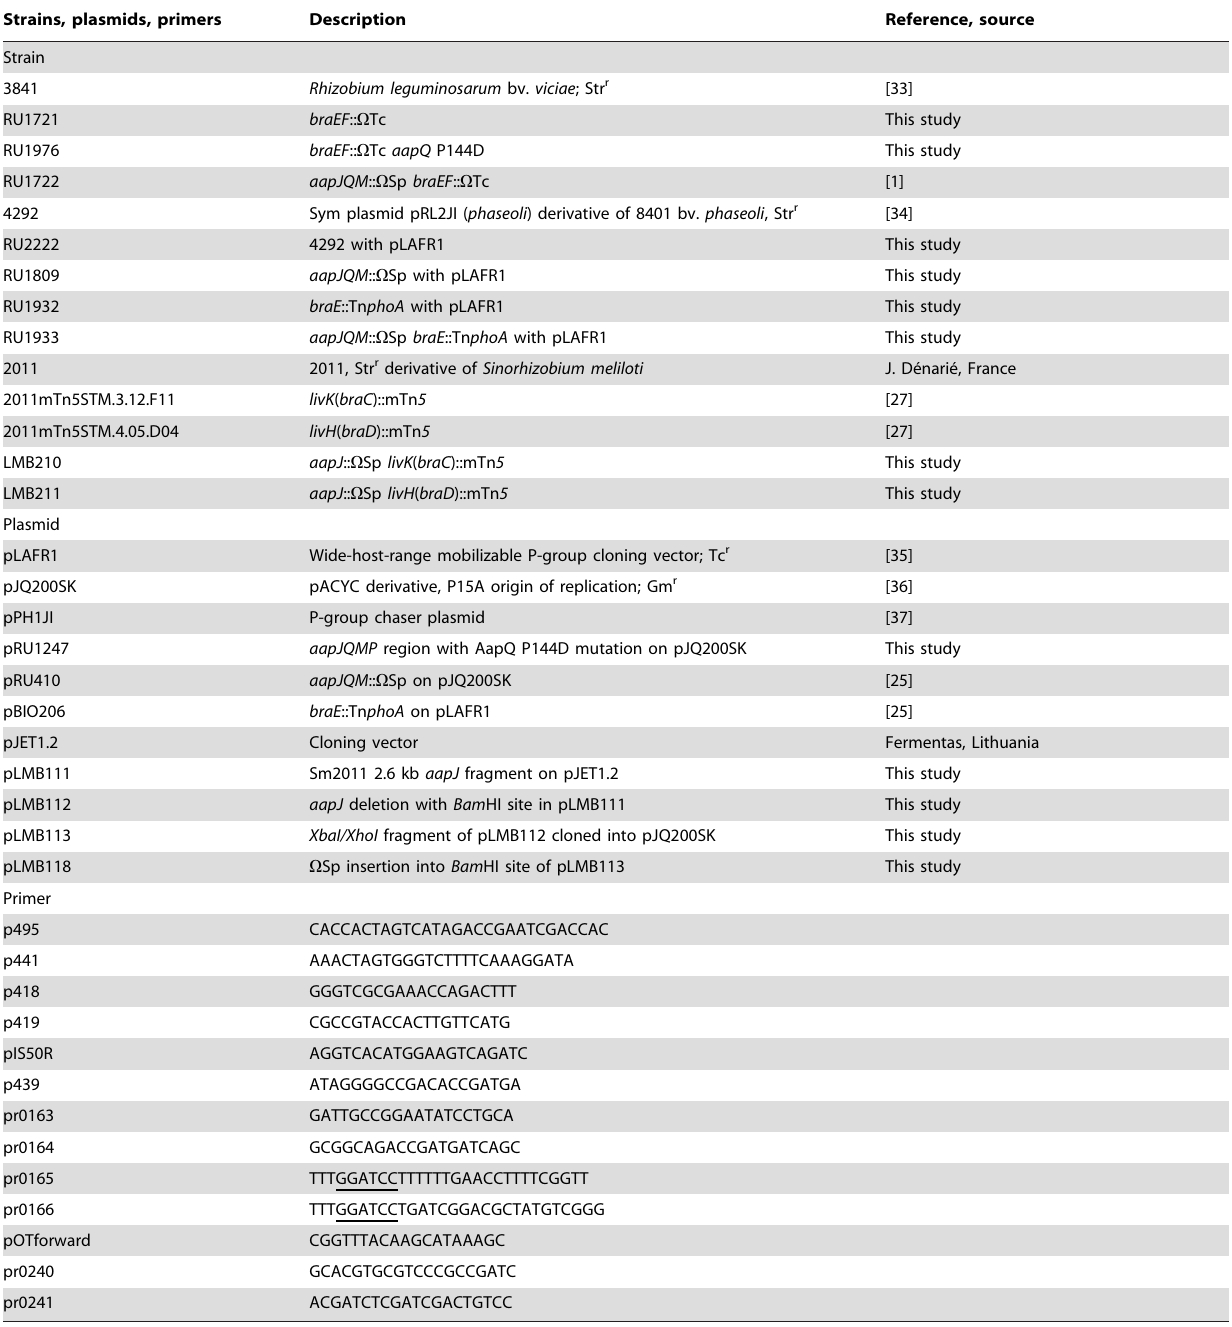
Strains, plasmids,